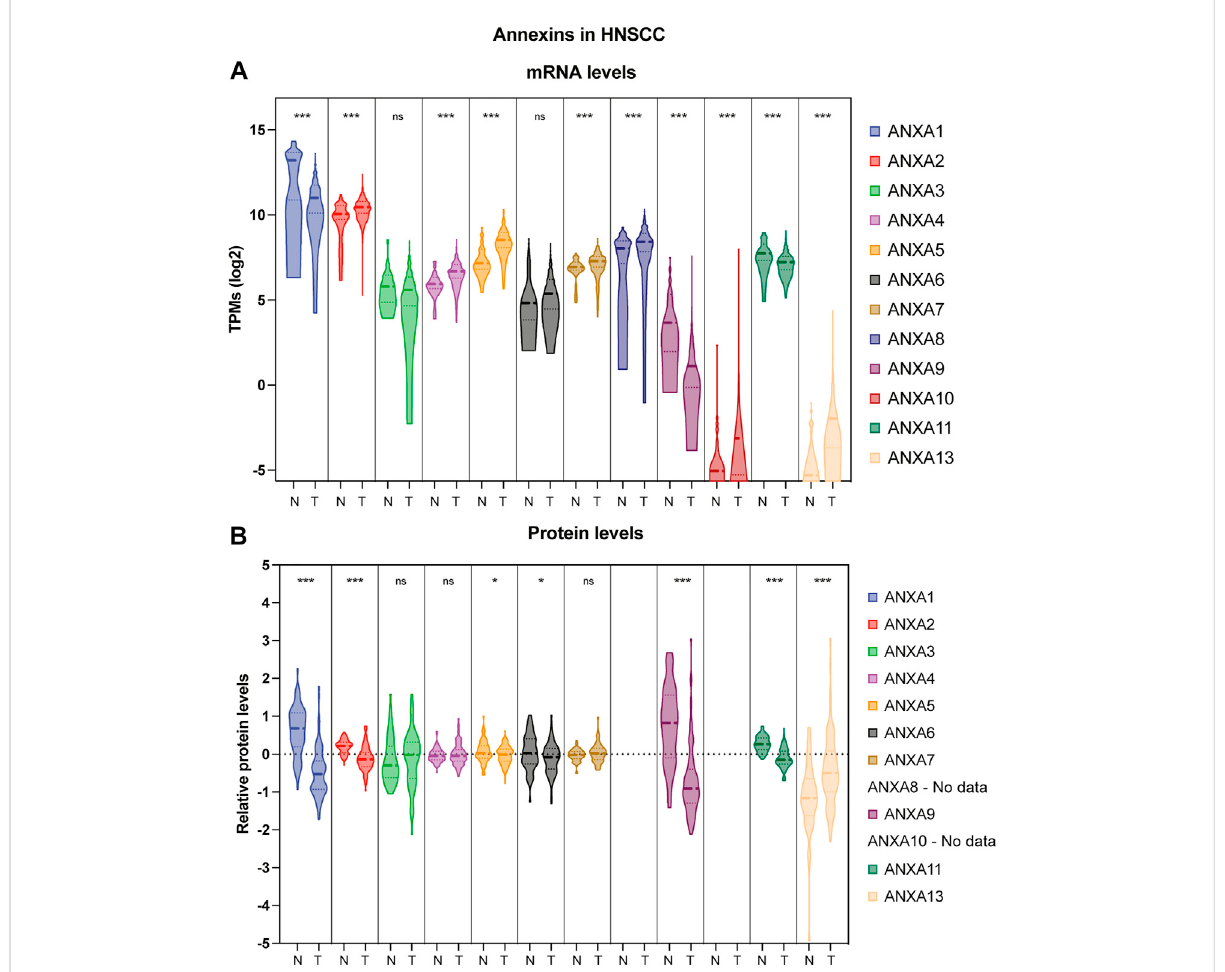
FIGURE 2 Violin plot comparison of annexin expression levels in HNSCC patient samples versus normal adjacent tissue. (A) Transcriptomic expression data were obtained at Xena repository (Goldman et al., 2020) from the TCGA-HNSCC cohort consisting of 44 normal adjacent tissue (N) and 522 primary tumors (T). Transcript per million (TPMs) are shown as log2 transformed (*** p < 0.001 by t -test using Welch ’ s correction; ns, not signi fi cant). (B) Proteomic expression data from 72 normal adjacent tissue (N) and 110 primary tumors (T) were obtained from Proteomic Data Commons (https://pdc.cancer.gov/pdc/study/PDC000221). Ion intensity is shown as log2 transformed (*** p < 0.001, * p < 0.05 by t -test using Welch ’ s correction; ns, not signi fi